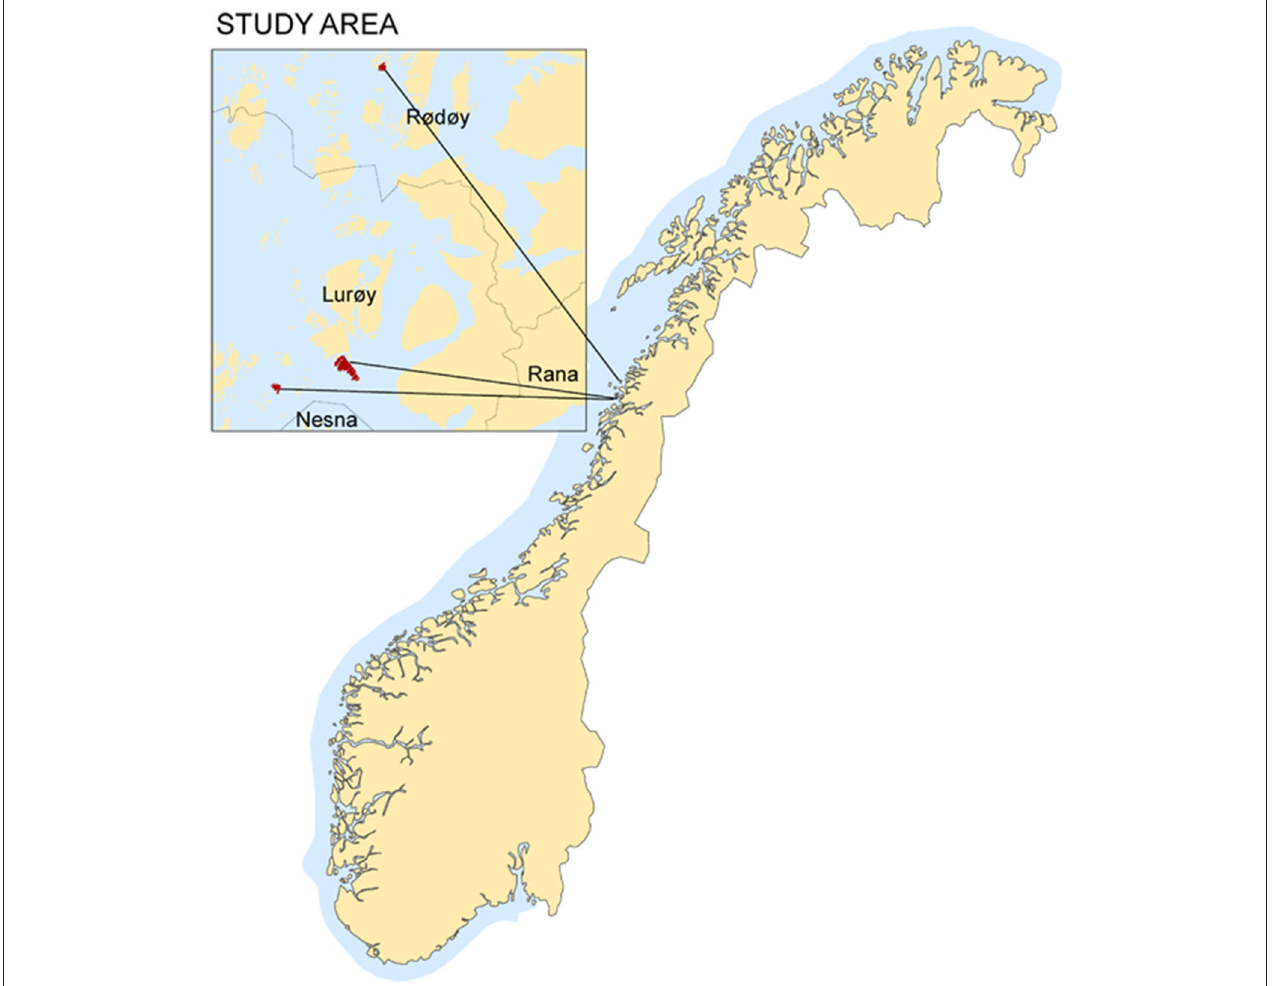
FIGURE 1 | Map of Norway and the islands (insert) Sandvær (south), Sjonøya and Buøya